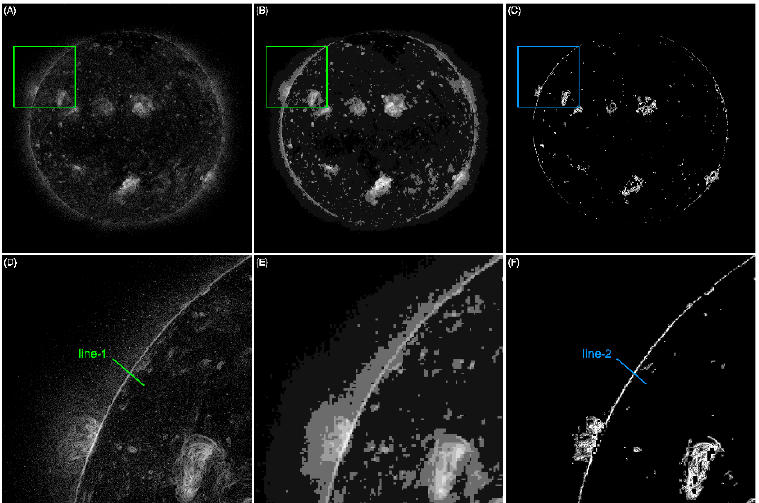
Figure 3. The images calculated by Sobel operator ( A ), the image calculated by FLICM algorithm ( B ), and the image after background removal ( C – F ) are the partially enlarged views corresponding to ( A – C ).